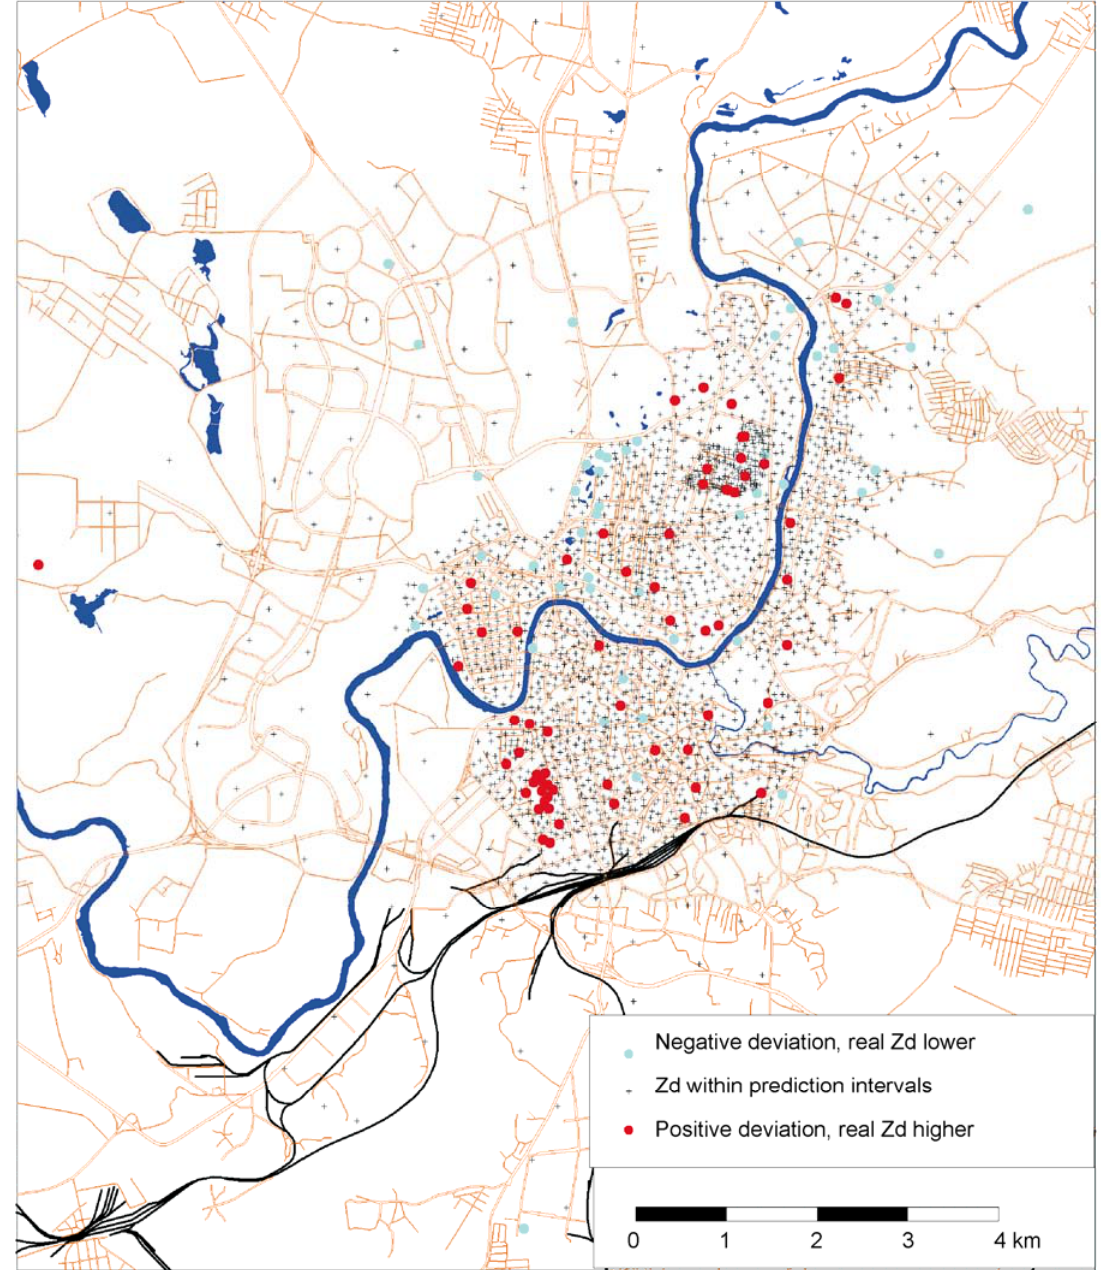
Fig. 5. Sampling sites within the linear regression 95 % prediction intervals for lg(Zd) according to S and outside these